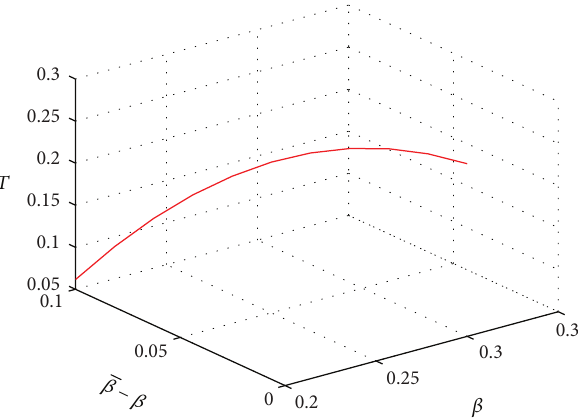
Figure 4: Diagram of the transferring payment in 𝛽 and 𝛽 − 𝛽 .